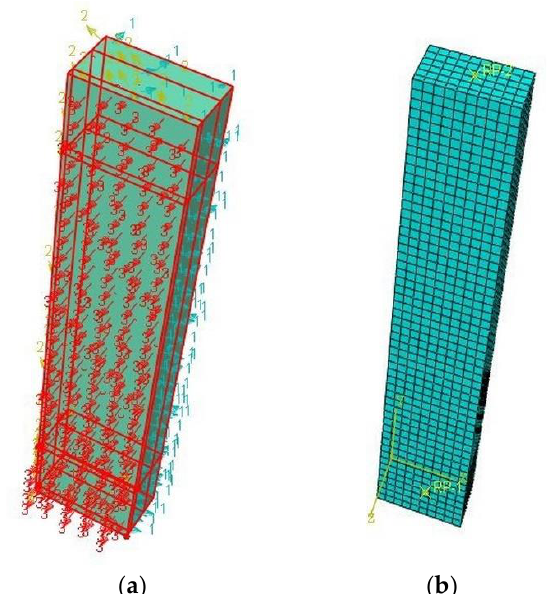
Figure 4. ( a ) Orientations of the fiber and ( b ) mesh in the tensile test specimen during the simulation.